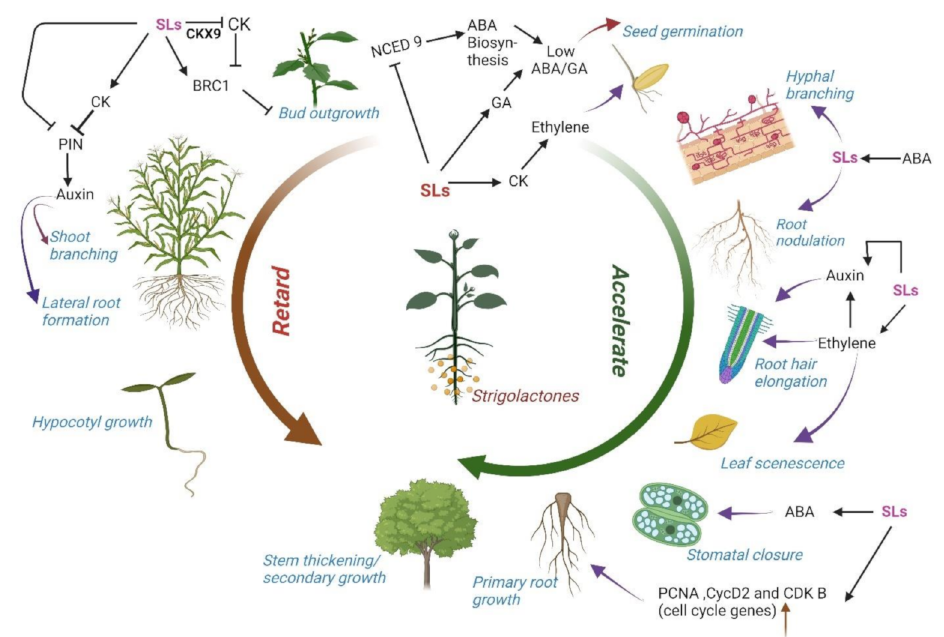
Figure 6. Coordinated role of strigolactones (SLs) with different hormones in regulating plant func- tions. There are certain phenomena that SLs either retard or accelerate. It needs coordinated crosstalk of different hormones and involvement of various genes to accomplish the outcome. Sometimes SLs may stop the synthesis or signaling of one hormone while promoting the other. In this way, homeostasis is maintained in the plant system in normal and stressed conditions. CKs (Cytokinins); ABA (Abscisic acid); gibberellins (GAs, BRC1 (BRANCH 1); CKX9 (Cytokinin Dehydrogenase); NCED 9 (9); Cyc D (Cyclin D); CDK (Cyclin dependent kinase); PCNA (Proliferating cell nuclear antigen); PIN (PIN FORMED; transporter protein). Promotes